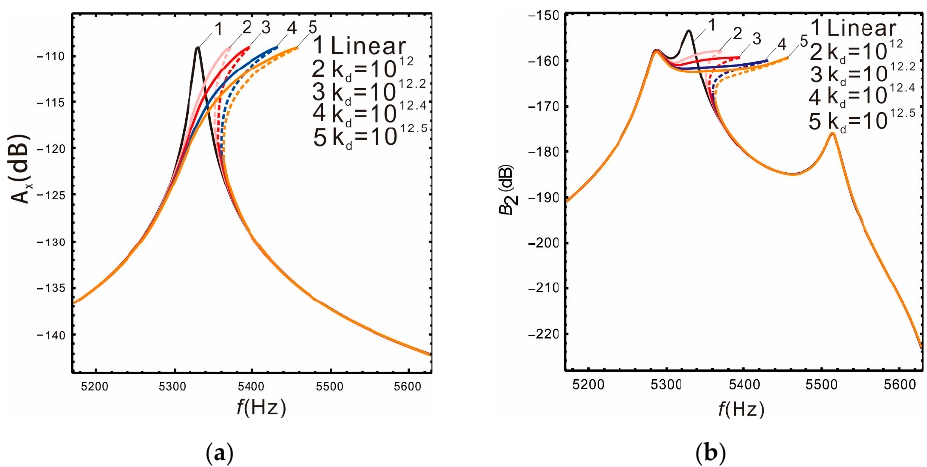
linear coefficients when the peak spacing is ∆ = 230 Hz . As the nonlinear coefficient in- creases, the bandwidth also increases gradually. See Table 4 for details.